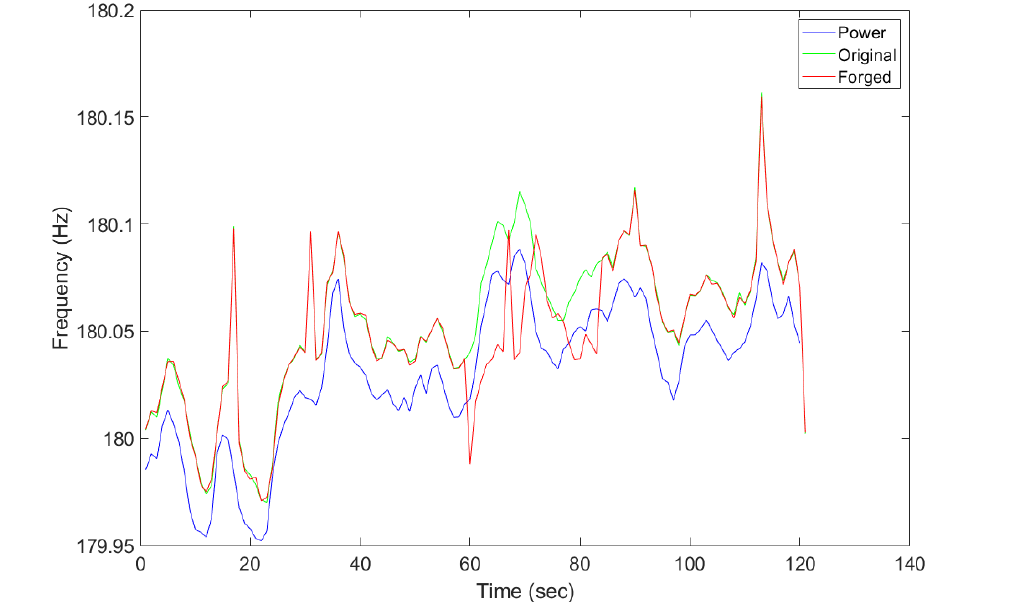
Figure 15. Comparing the recording collected by the attacked, original, and power recordings.